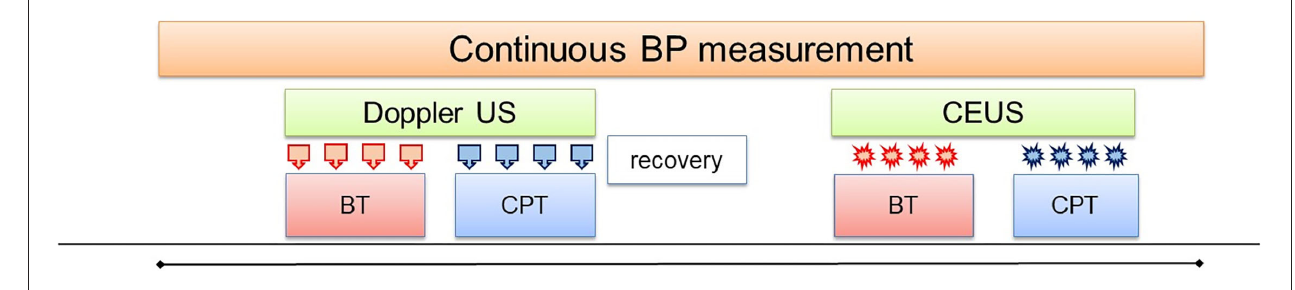
FIGURE 1 | Study design. Both feet were placed in a water bath initially filled with water at body temperature (BT) for baseline Doppler US measurements ( ). Thereafter, the water was replaced by cold water (2–4 ◦ C) for 2min for the measurements during the CPT. In the second phase, the same procedure was repeated for the CEUS measurements (